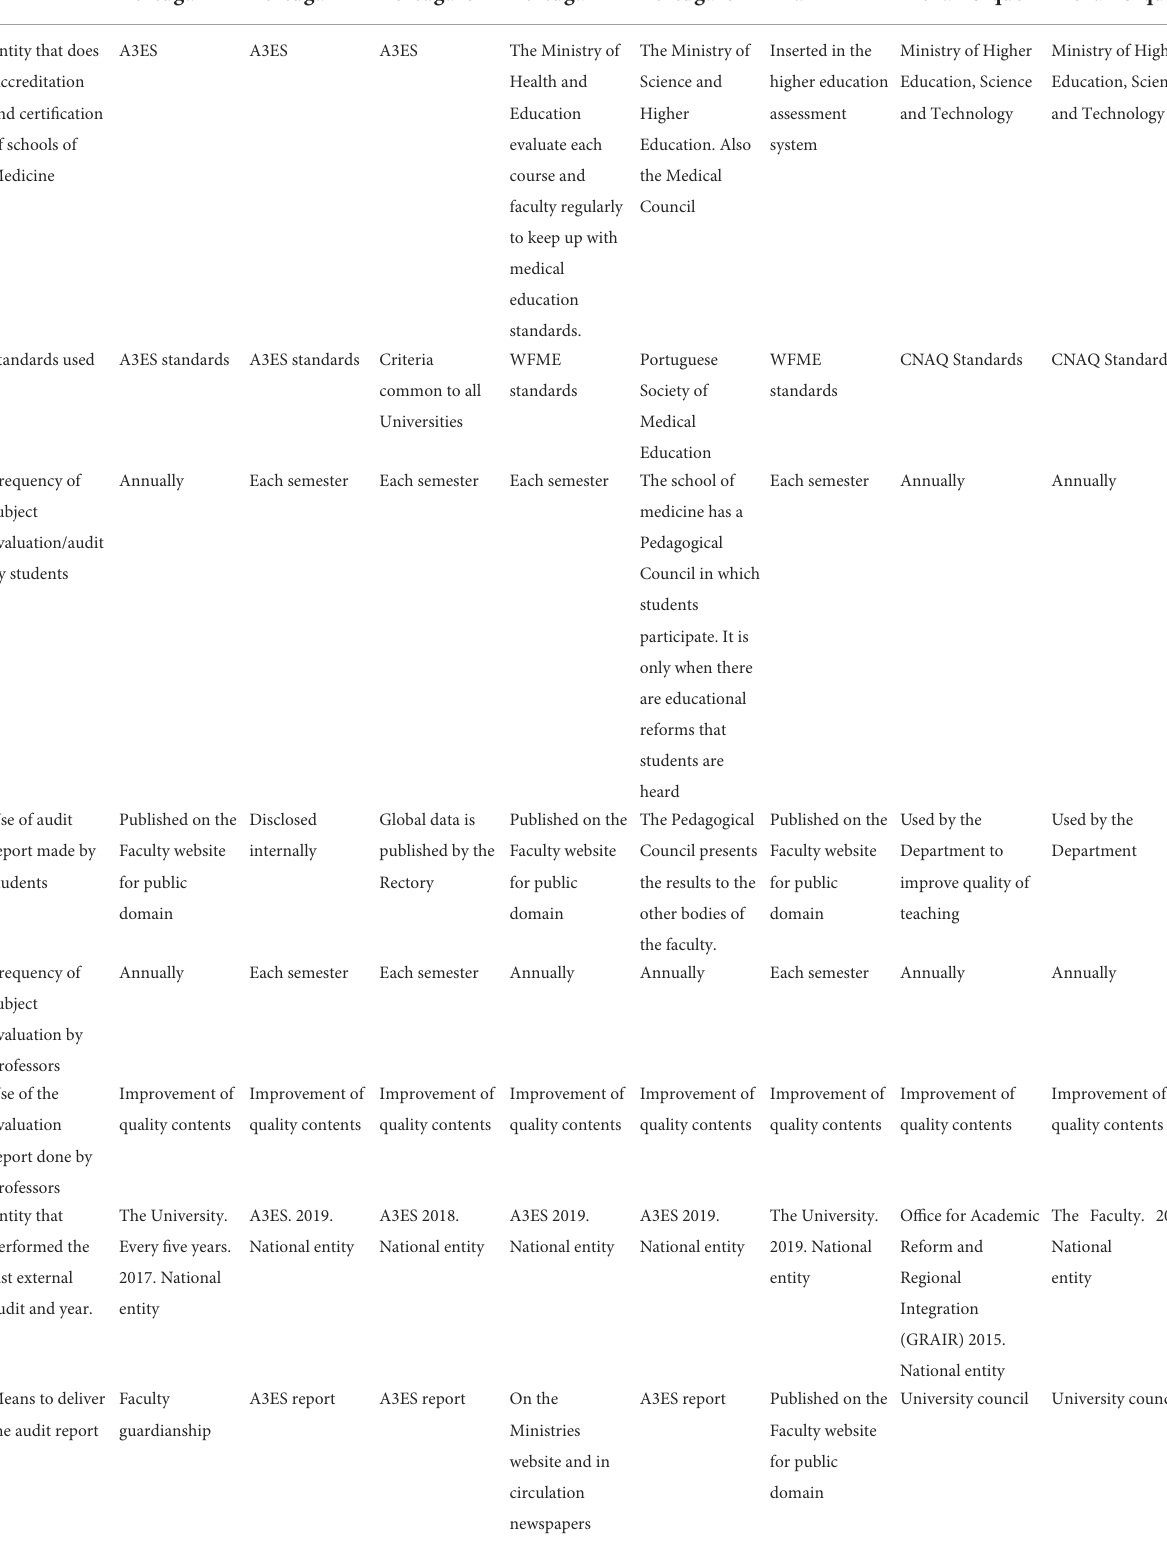
TABLE 1 Process control and commitment to